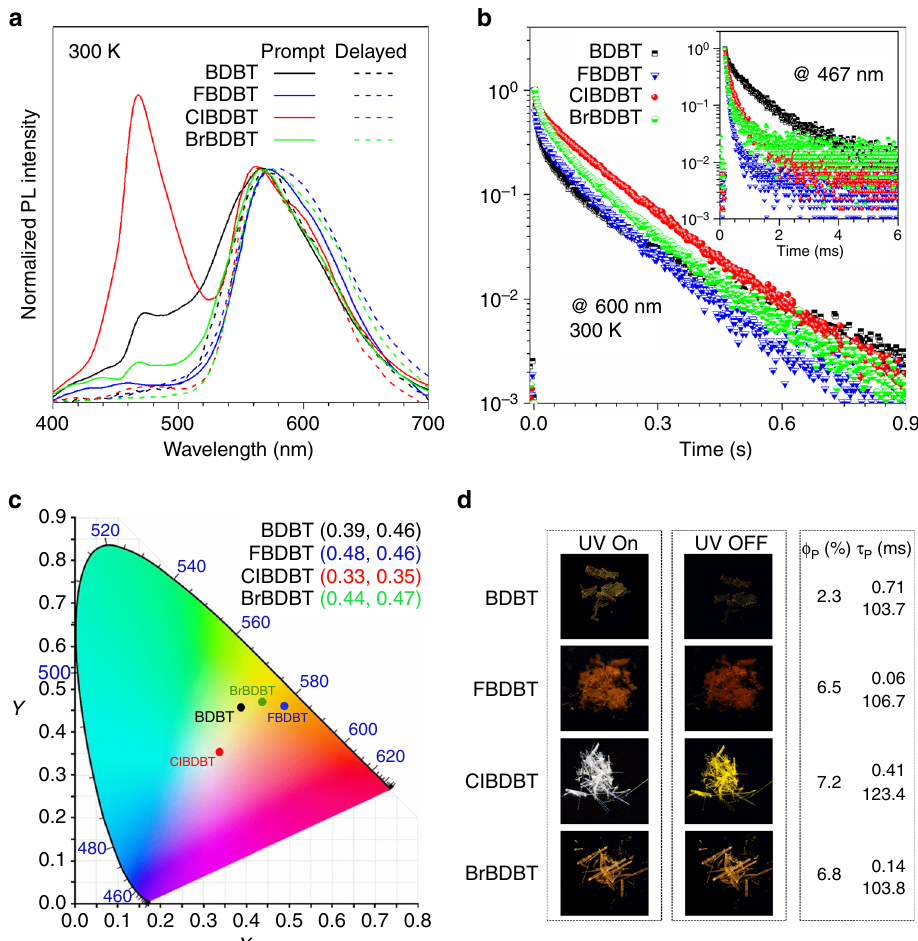
Fig. 2 Photophysical properties of BDBT, FBDBT, ClBDBT and BrBDBT. a The prompt ( solid line ) and delayed ( dash line , 10 ms) PL spectra of the crystalline powders of BDBT, FBDBT, ClBDBT, and BrBDBT at 300 K. b PL decay curves of 1 – 4 measured at 600 nm for persistent emission and at 467nm for fast emission ( inset ) at 300 K. c CIE 1931 coordinates of prompt emission of BDBT, FBDBT, ClBDBT, and BrBDBT. d Photographs of BDBT, FBDBT, ClBDBT, and BrBDBT taken before and after the removal of excitation source and their phosphorescence quantum yields and lifetimes. The excitation was 365